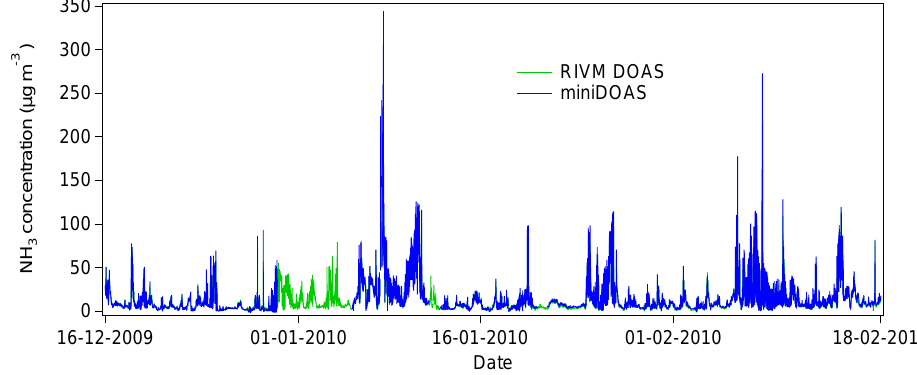
Fig. 13. RIVM DOAS (5-min values) and miniDOAS data (1-min values) obtained in the field in Vredepeel from 16 December 2009 to 18 February 2010.